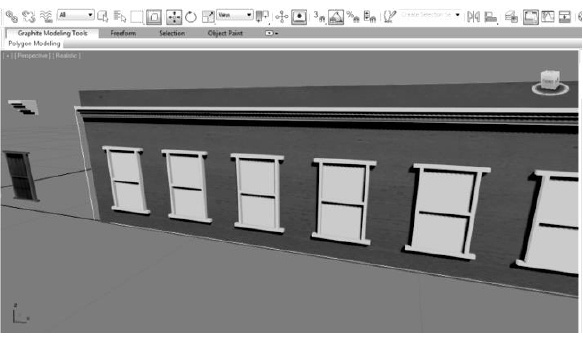
Figure 10. Archway component, gargoyles included.